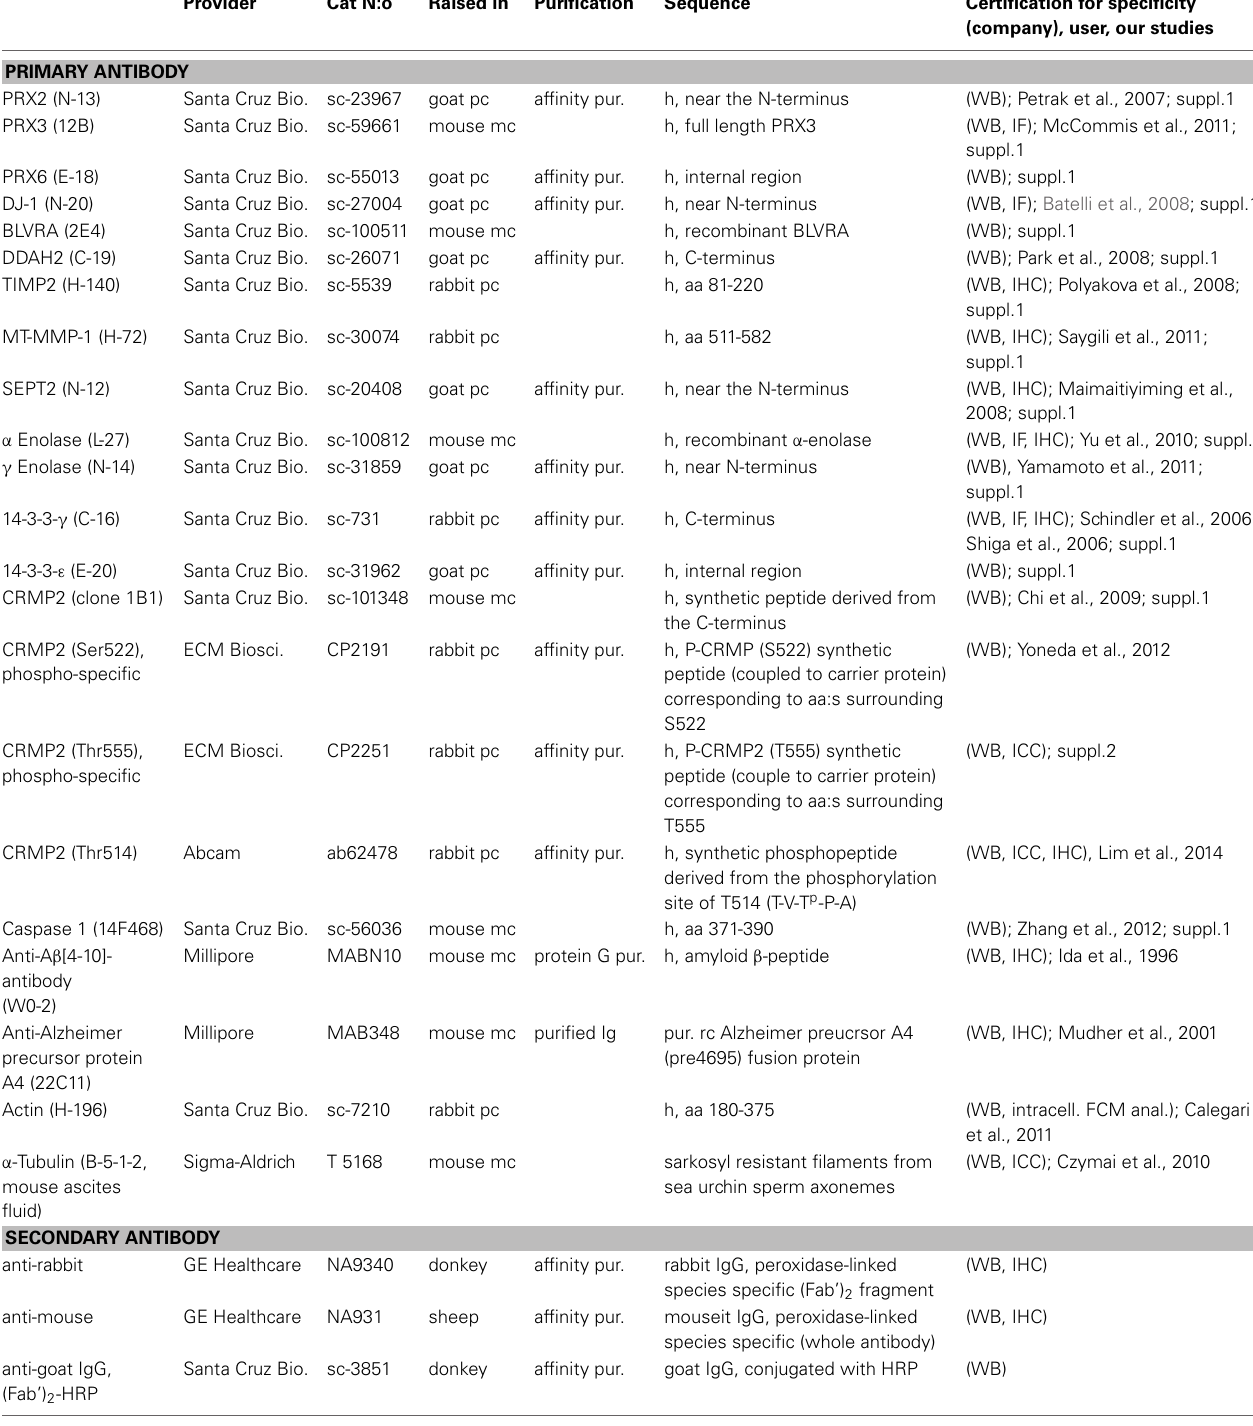
(company), user, our studies